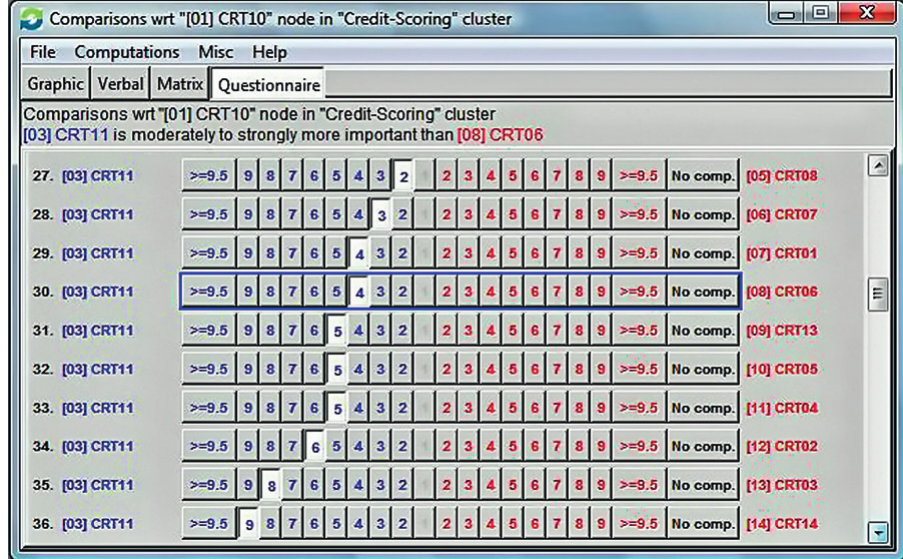
Fig. 3. Questionnaire of judgments [Super Decisions Table 3. Criteria ranking and “new” trade-offs Criteria